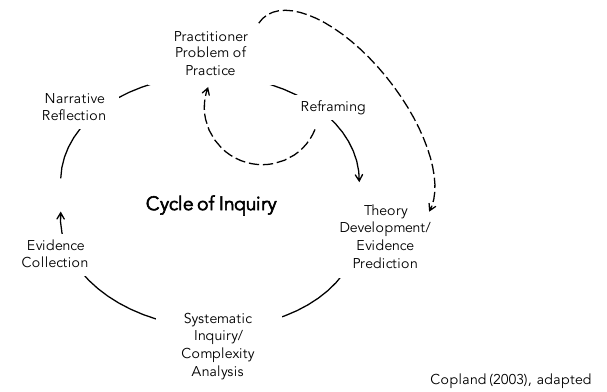
Figure 2. Cycle of inquiry with embedded practitioner problem of practice. Adapted from “Leadership of inquiry: Building and sustaining capacity for school improvement” by M. Copland, 2003, Educational Policy and Analysis, 25(4), 375-396. Adapted with